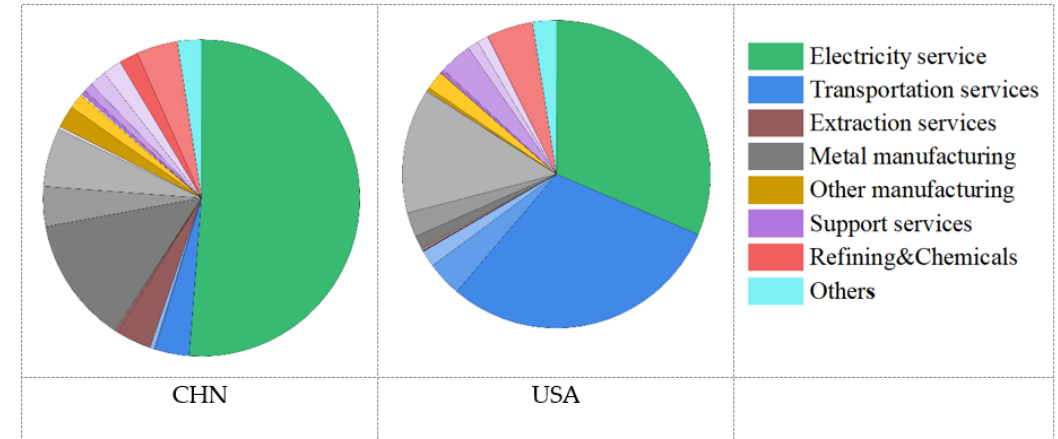
Figure 5. Embodied emission intensity structure of coal production.